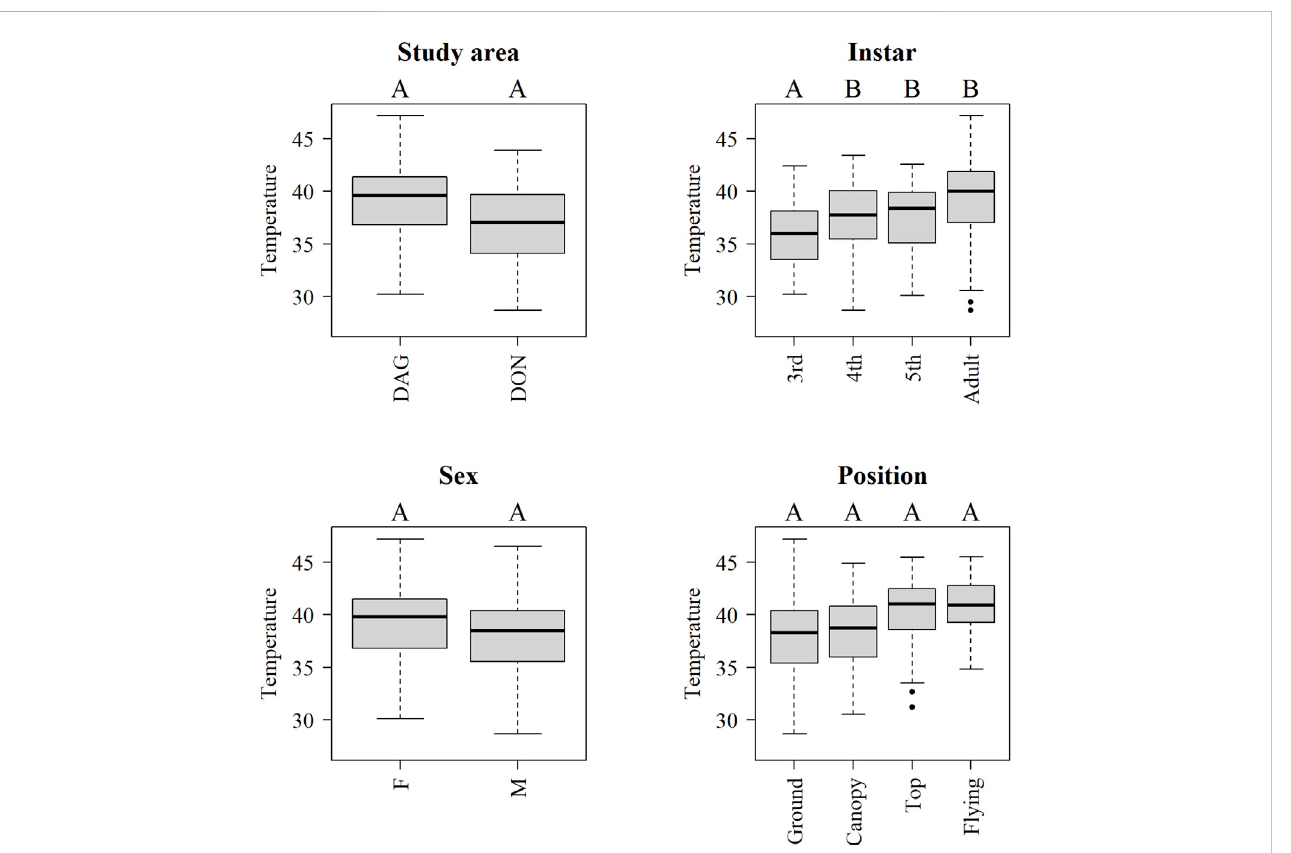
FIGURE 6 Boxplots of internal body temperature of Locusta migratoria manilensis across provinces (DAG-Dagang, DON-Dongying), instar, position and sex (F-female, M-male) at daytime (6:00 – 18:59). Letters above each level indicate signi fi cant differences ( p < 0.05) between levels in a mixed model including all indicated factors and controlling by ambient temperature and